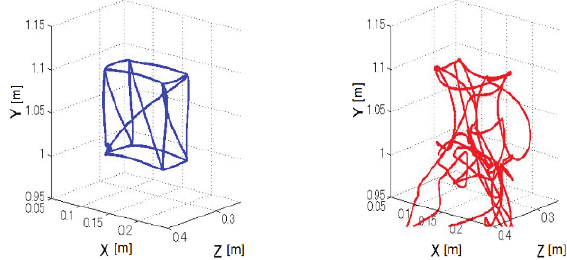
Figure 9. Task space trajectory of the hand during the test movement, after motor babbling was performed first without and then with the tool. On the left: using IMLE. On the right: using LWPR.